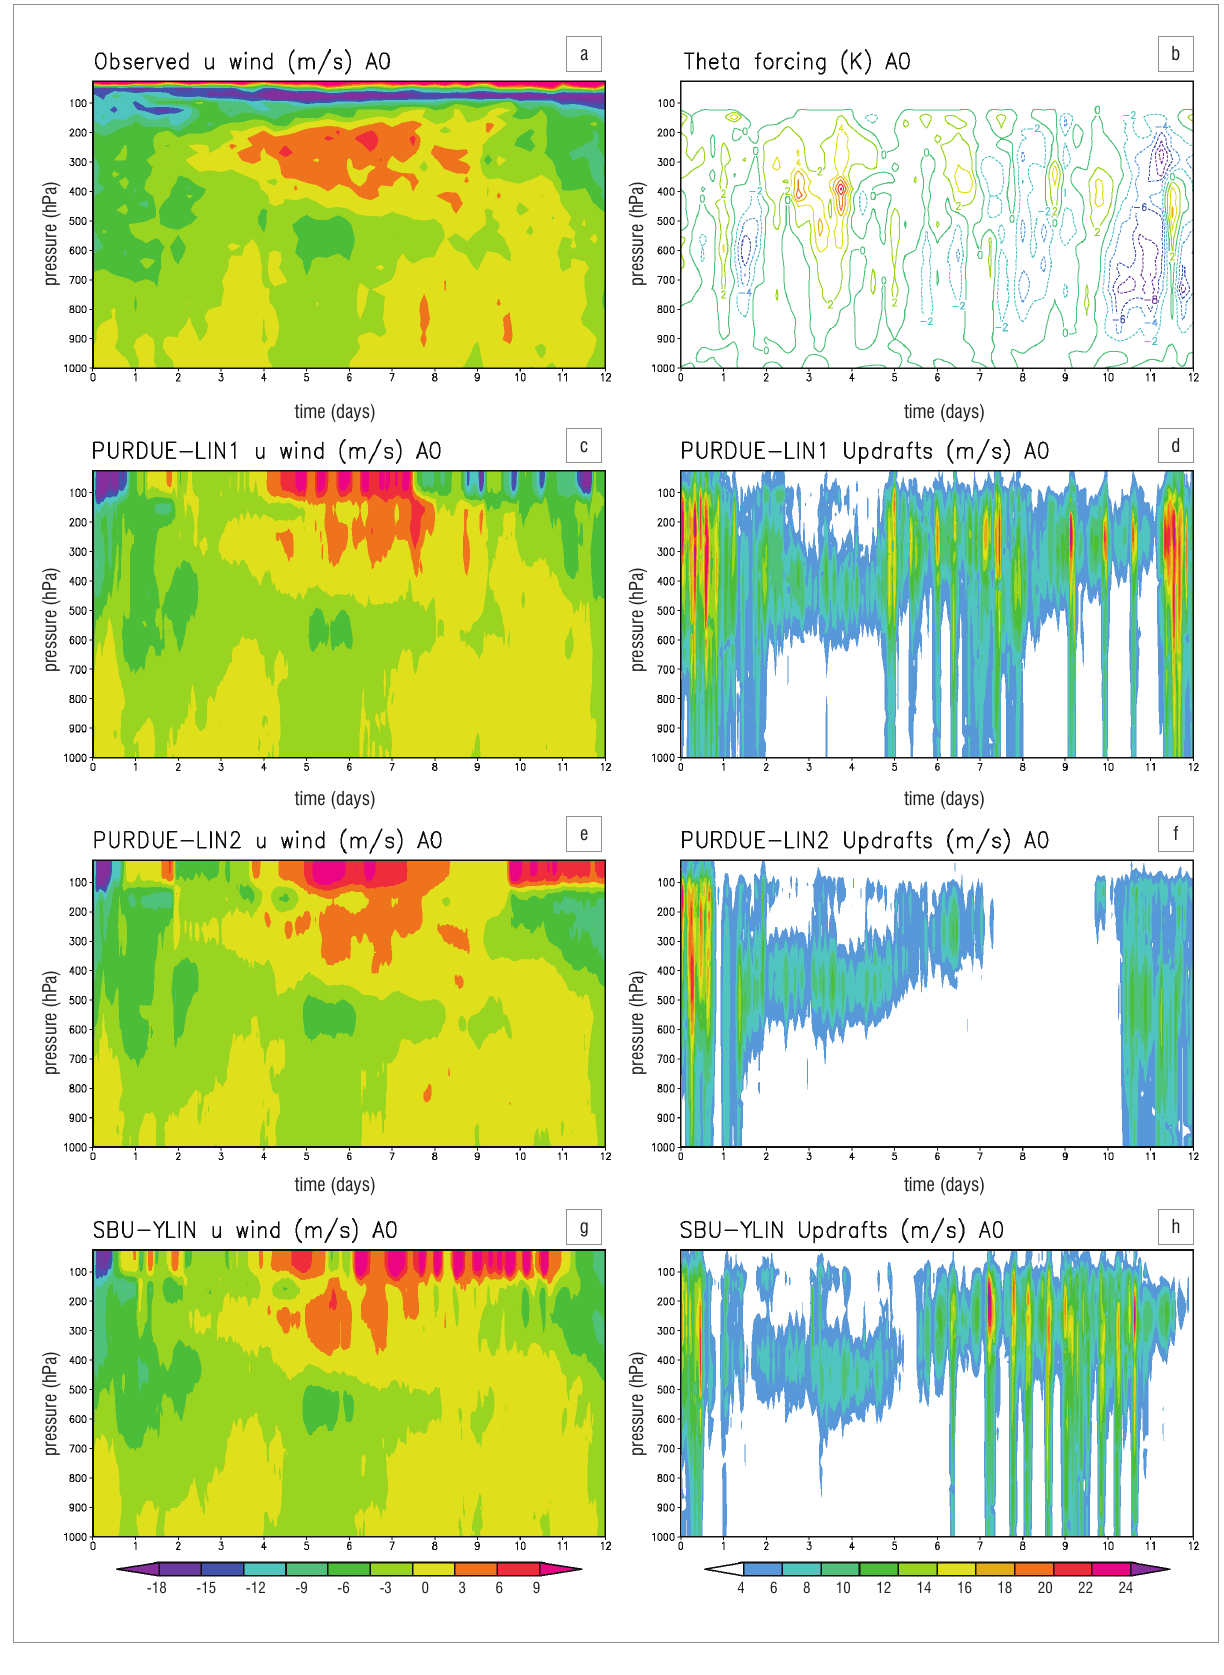
Figure 4: The temporal evolution of the (a) observed and (c,e,g) simulated average horizontal wind by the different schemes. (b) The large-scale warming or cooling applied to the Non-hydrostatic σ -coordinate Model over a 12-day period. (d,f,h) The temporal evolution of the simulated maximum updrafts across the domain by the different schemes over a 12-day period for the A0